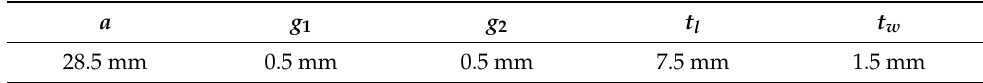
Table 3. Reconfigurable HCPBG